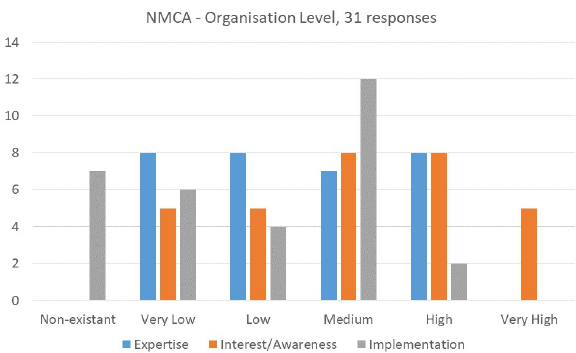
Figure 1: Levels of interest, expertise and implementation of Digital Twins - Organisational Level - NMCA